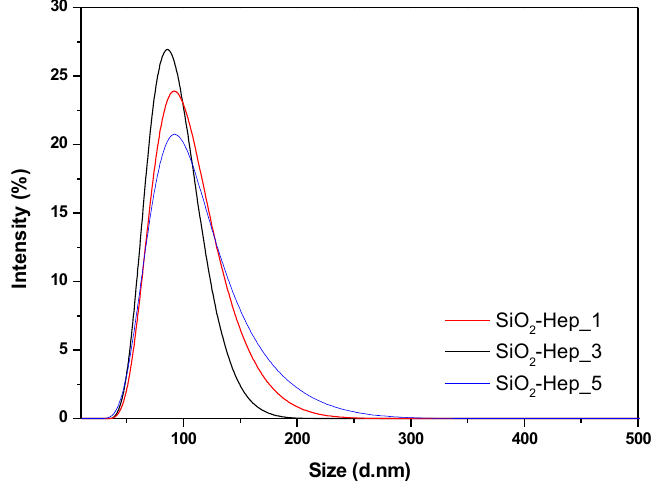
Figure 4. DLS number distributions of SiO 2 -Hep_1, SiO 2 -Hep_3, and SiO 2 -Hep_5 NPs.